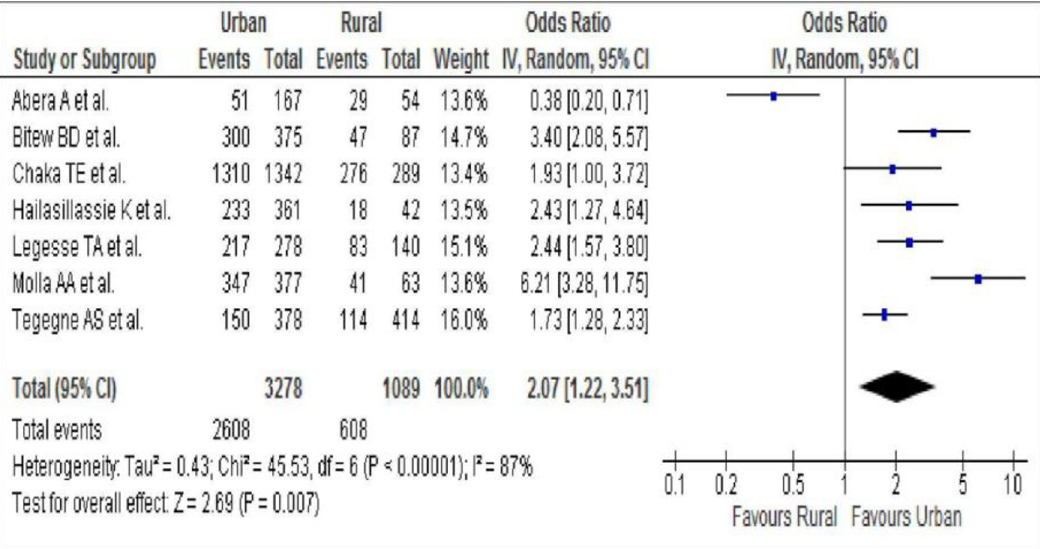
Fig 2. Pooled association between ART adherence and place of